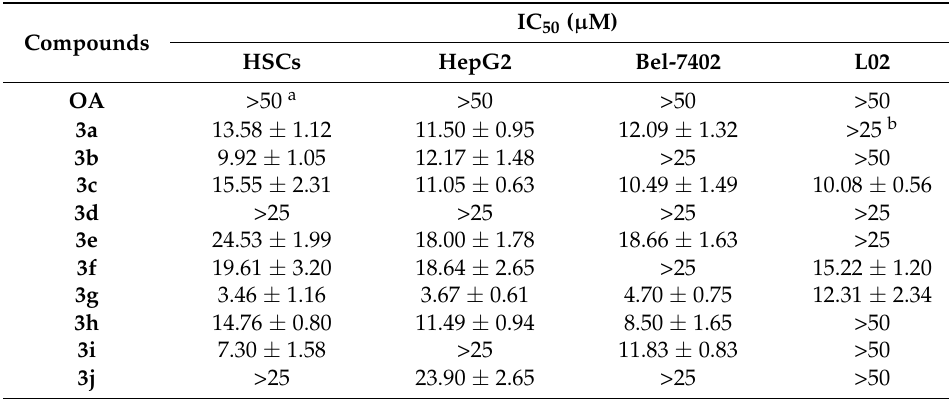
Table 1. In vitro biological activities of OA-amide acids derivatives.